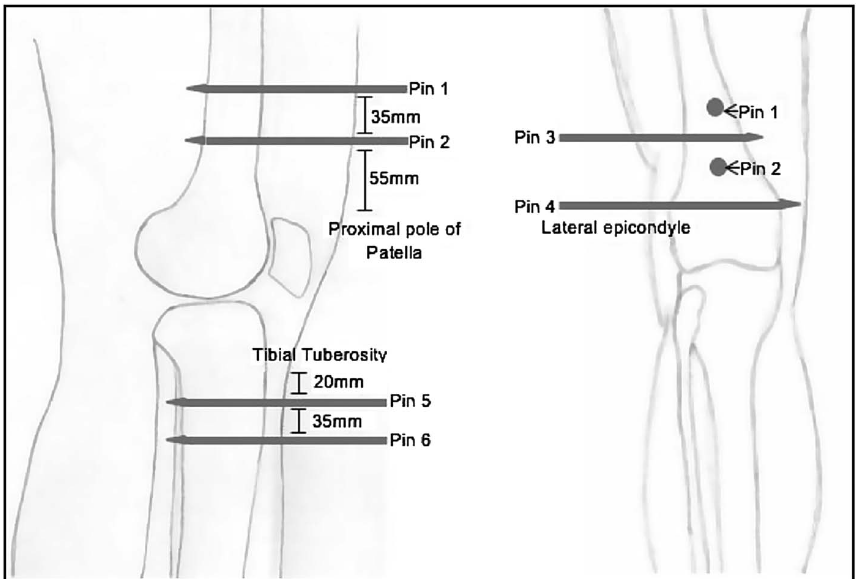
Figure 1. This fi gure illustrates the positions of the six EF pins and shows how the tips of the EF pins pass through to the other side of the bone, endangering the neurovasculature. The pins were placed speci fi cally about the knee, within the metaphyseal/metadiaphyseal portions of the tibia/femur relative to the knee joint. The focus was on proximity that the EF pin tips obtained to the neurovascular bundle within these areas, as opposed to the stabilization